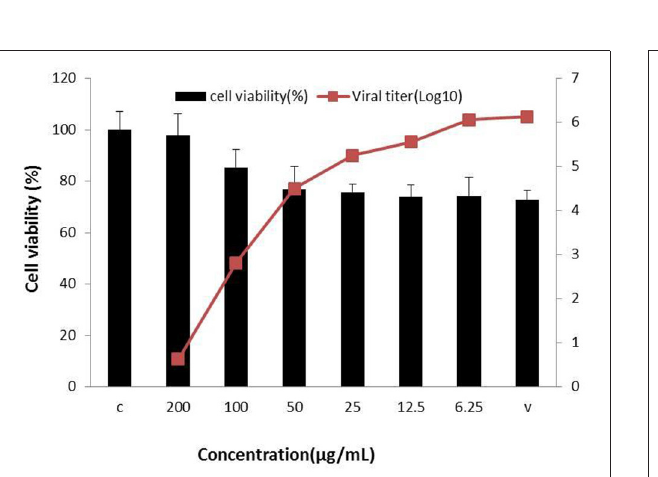
FIGURE 3 | Ginsenoside Rb2 antiviral activity against bovine viral diarrhea virus (BVDV). All serial dilutions Rb2 concentrations were used and uninfected and virus infected cells were controls.